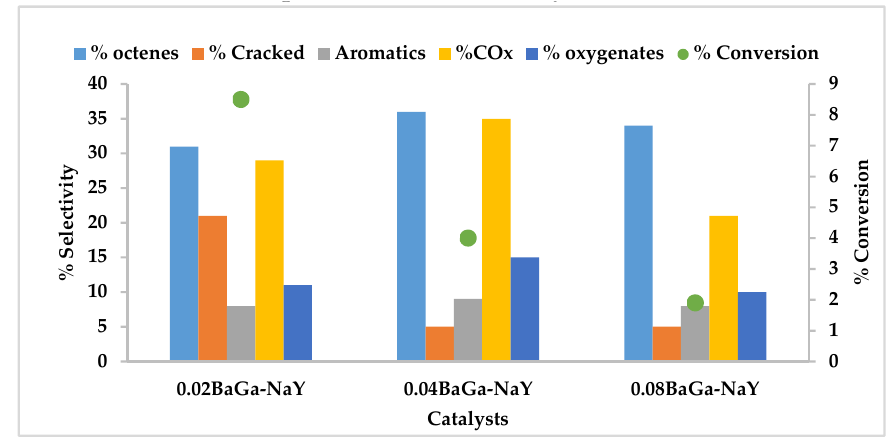
Figure 6. Effect of Ba metal content on the conversion of n ‐ octane and selectivity towards cracked products, aromatics, carbon oxides, oxygenates and octene isomers at a temperature of 450 °C, C:O ratio of 8:1 with the GHSV fixed at 8000 h − 1 .